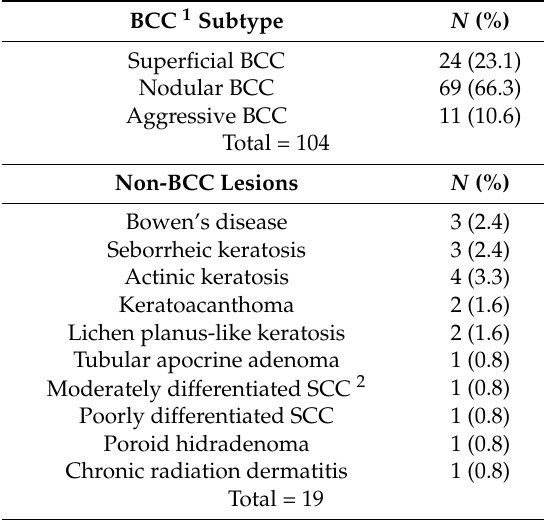
Table 1. Characteristics of patients and imaged